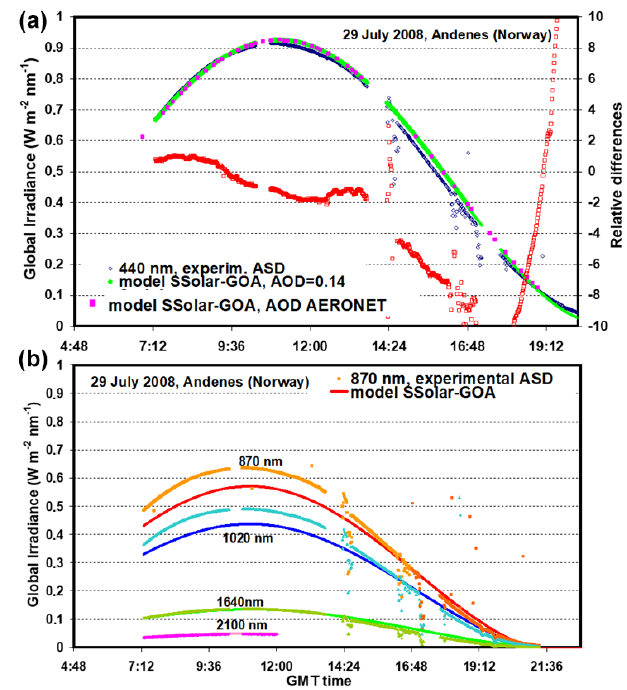
Figure 11. Comparison between the ASD measurements (dark blue line) and the SSolar-GOA model (green line) for the global spec- tral irradiance at 400nm as a function of GMT on 29 July 2008, at Andenes (Andøya Island, Norway). The rose points overlapping the green line are also modelled points at the specific time, and the AOD values are given by AERONET Cimel Sun photometer. At the bottom graph, the lines also give measured and modelled global irradiance values for different wavelengths (orange–red is 870nm, light and dark blue is 1020nm, dark and light green is 1640nm, dark and light rose is 2100nm).